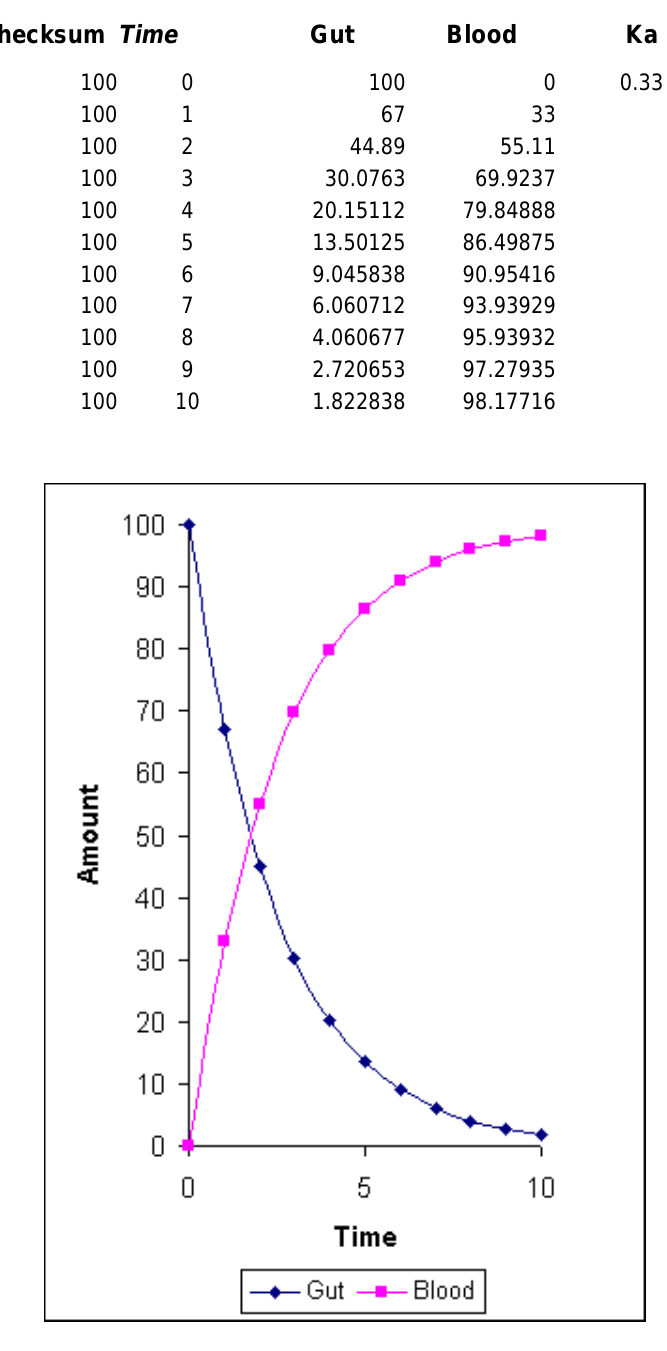
Calculated Values after Running the Spreadsheet Shown in Table 1 Checksum Time